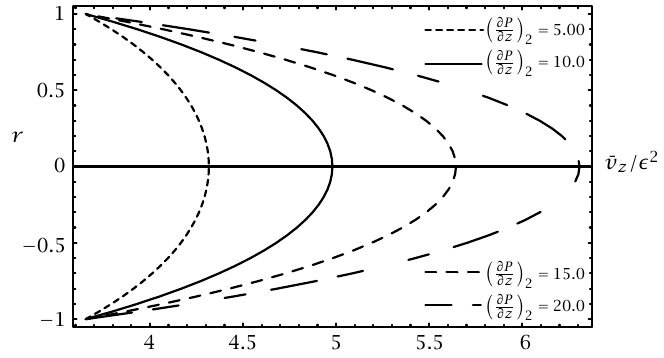
− 1 Figure 6.8 . The effect of the mean second-order pressure gradient (∂P/∂z) 2 on the mean-velocity distribution and reversal flow at Re = 1 . 0, k = 0 . 5, and α = 0 . 1.